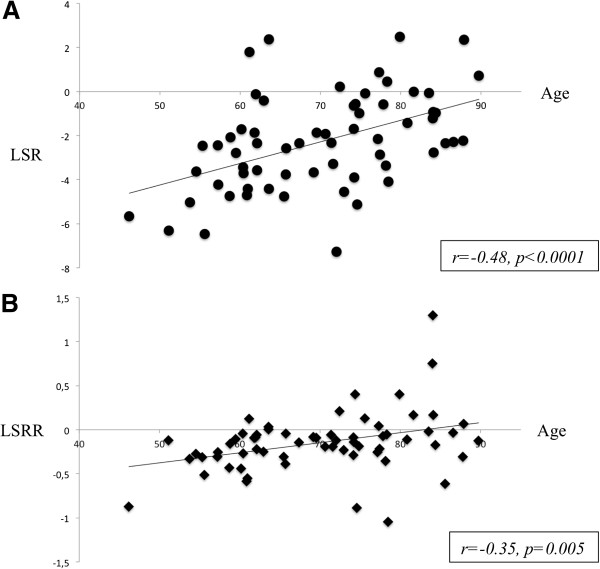
Impact of age on LSR and LSRR A. Correlation between increasing age and decreased longitudinal strain rate reserve in Panel B. LSR = longitudinal strain reserve, LSRR = longitudinal strain rate reserve.